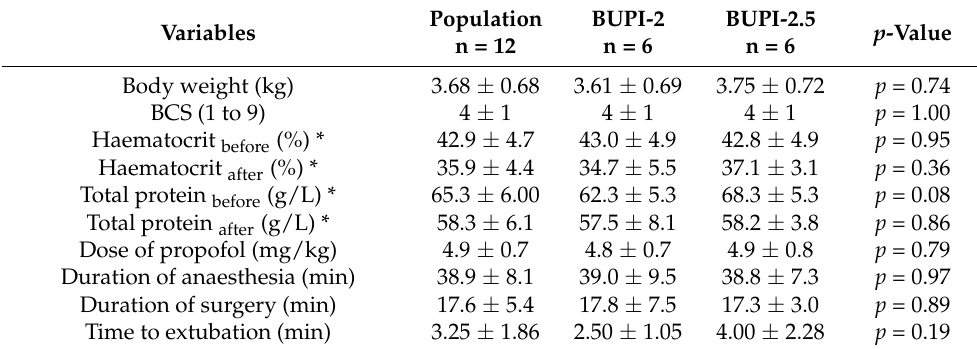
Table 1. Body weight, body condition scores (BCS), haematocrit, total protein, the dose of propofol for anaesthesia induction, duration of anaesthesia and surgery, and time to extubation in cats undergoing ovariohysterectomy after administration of bupivacaine 2 mg/kg (BUPI-2) or 2.5 mg/kg (BUPI-2.5) by bilateral ultrasound-guided transversus abdominis plane